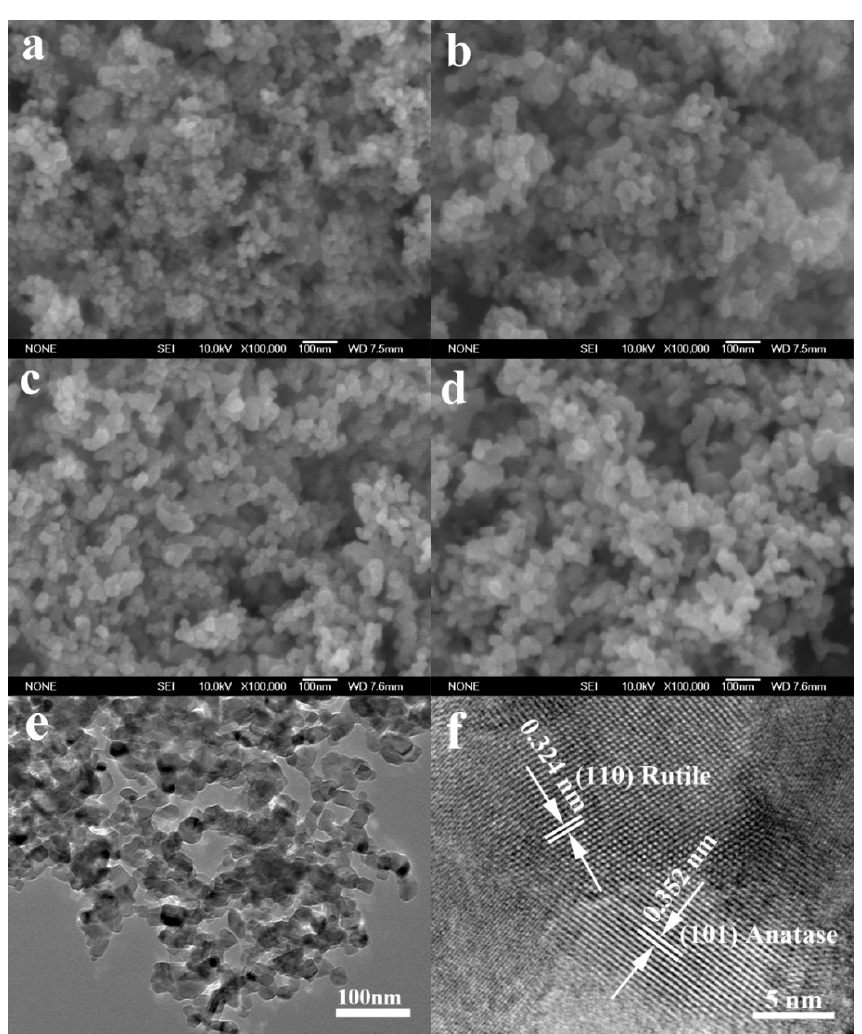
Figure 2. FE-SEM images of TiN ( a ), N-TiO 2 -400 ( b ), N-TiO 2 -500 ( c ), and N-TiO 2 -600 ( d ); TEM ( e ) and HRTEM ( f ) images of N-TiO 2 -500.